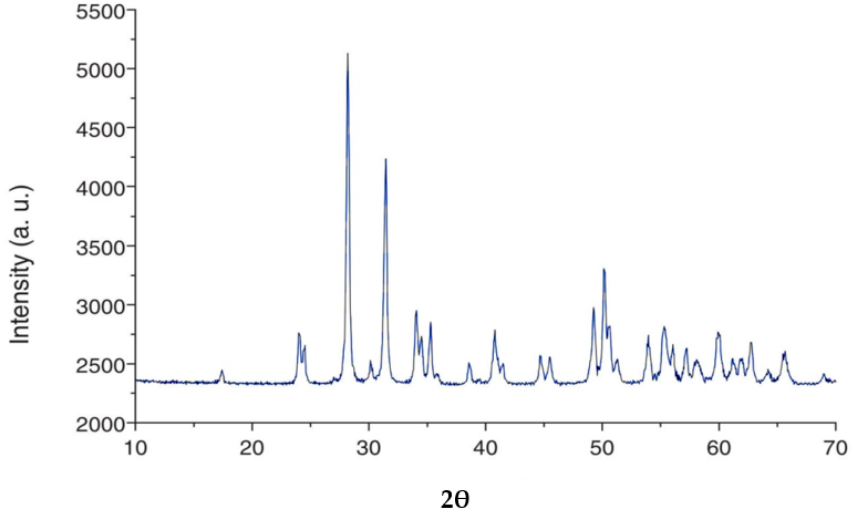
Figure 16. XRD diffractogram of highly pure ZrO 2 from Egyptian Zircon sand.